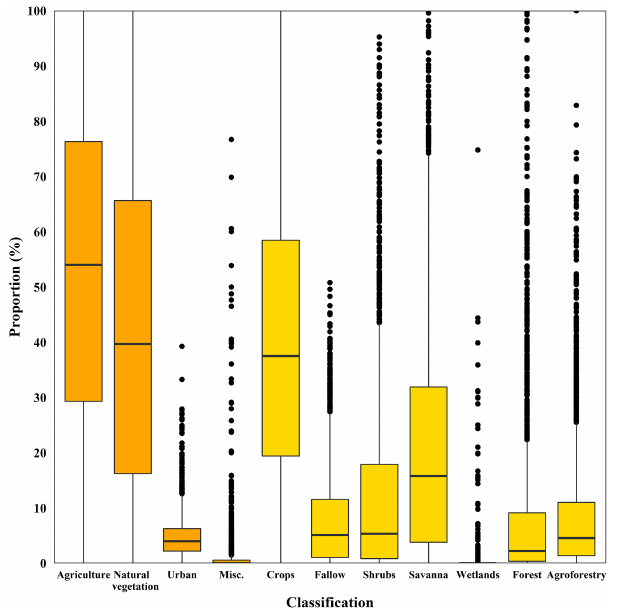
Figure 3. Box plot of the proportion of land cover types for two levels of classification ( N = 2252). The first and second levels of classification are shaded in orange and yellow,